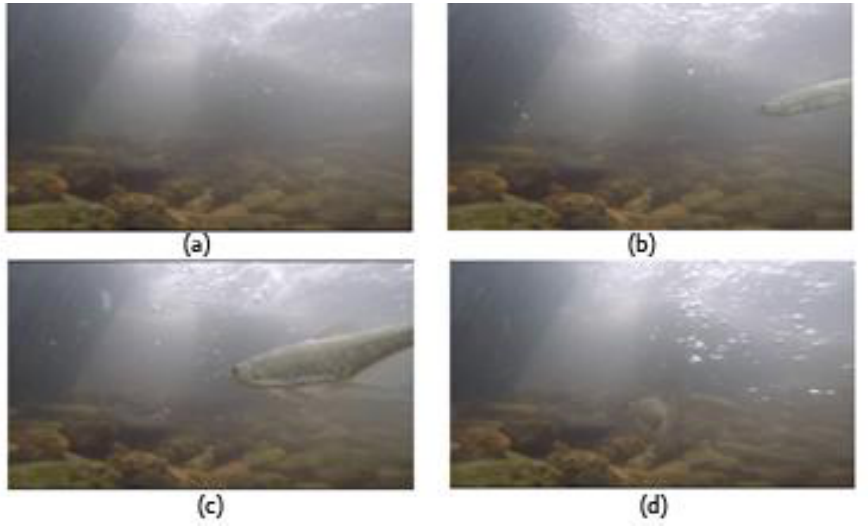
Figure 14. Video frames, with a time frame of 0.01 s, inside the brush fish passage showing the upstream migration of Alburnoides fasciatus individuals. ( a ) t 0 = 7:71 s, no fish is seen in the flow field; ( b ) t 1 = 7:72 s, first individual pass; ( c ) t 2 = 7:73 s, following of other individuals; ( d ) t 4 = 7:74 s fish schooling.